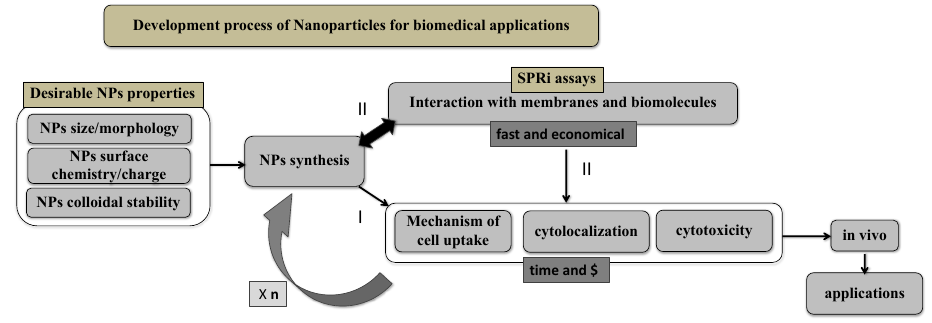
Figure 10. Flowchart of an example of how the SPRi assays could be incorporated in the development process of NPs for biomedical applications providing fast and less expensive assays to predict in vitro results. As soon as NPs synthesis is finished, their biological interactions could be evaluated by SPRi (step II) instead of following it directly to in vitro assays (step I) which are time-consuming and expensive. SPRi assays are faster and of low cost. During the NPs development process, the synthesis has to be adjusted “ n ” times after the evaluation of in vitro results. SPRi assays provide a much more practical technique to adjust the synthesis and biological behavior of NPs.